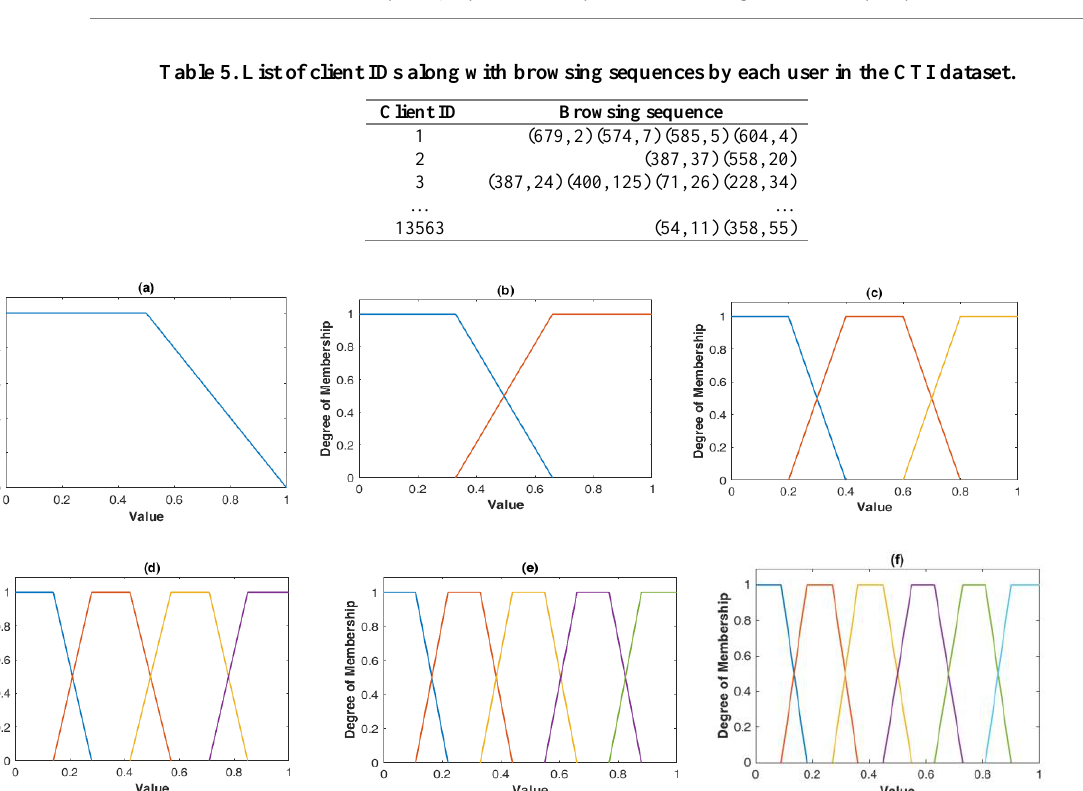
Figure 9. The pre-defined membership functions with different numbers of linguistic terms used in the